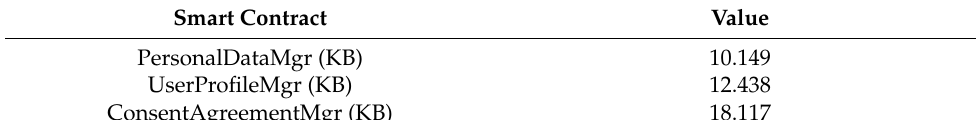
Table 7. Space complexity of core smart contracts.